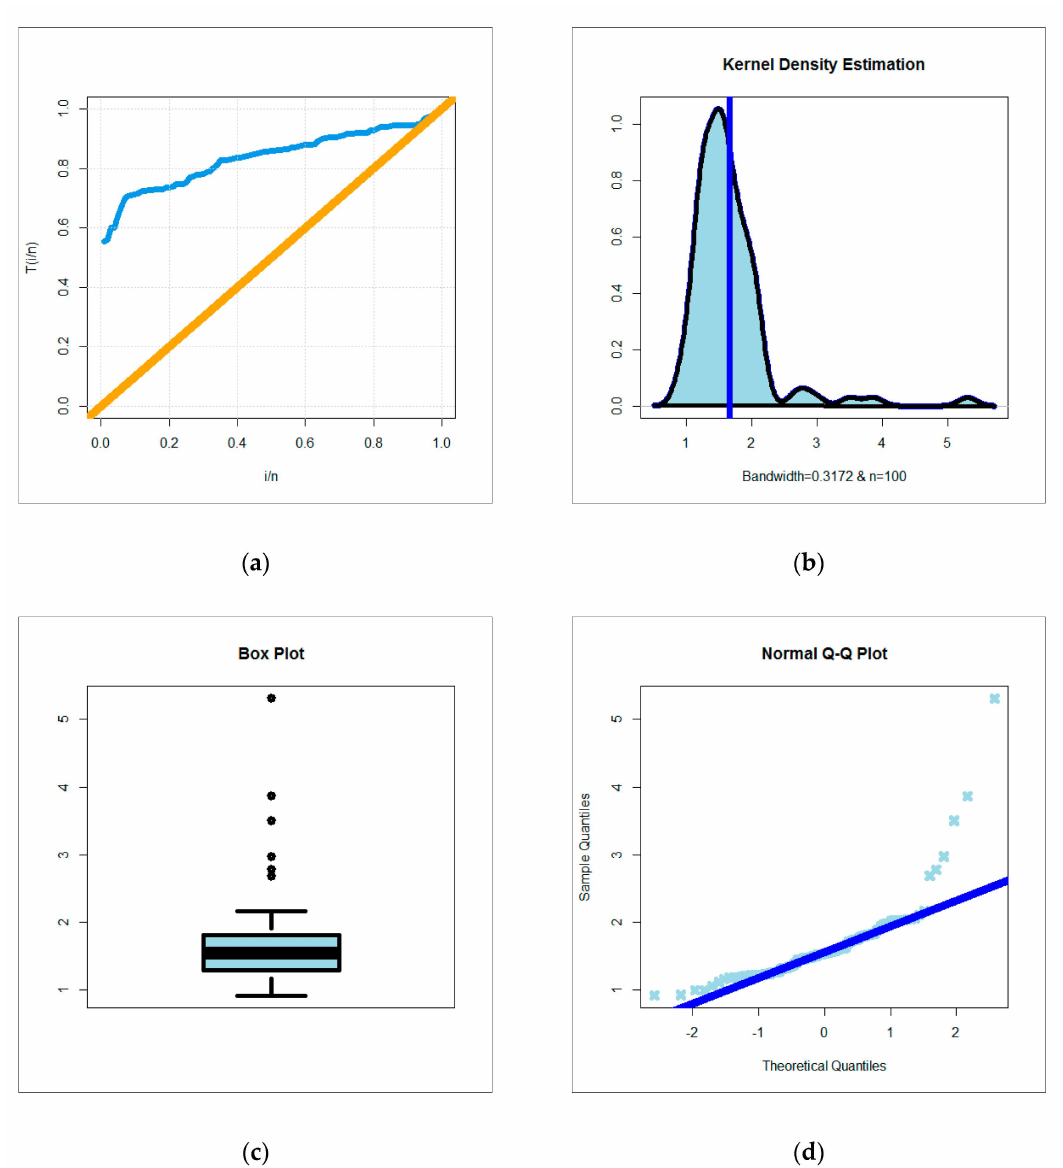
Figure 2. ( a ) Total time test (TTT) plot; ( b ) Kernel density estimation (KDE) plot; ( c ) box plot; ( d ) quantile–quantile (Q–Q) plot for data set I